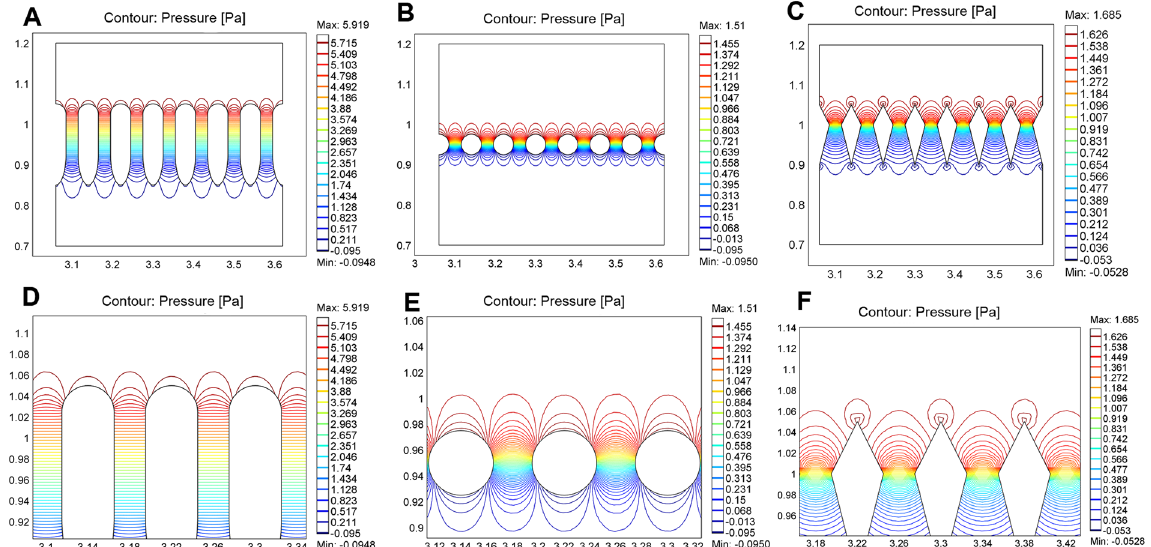
Figure 2. Comparison of pressure contours for three microfluidic chips composing of three distinct microposts. ( A ) Pressure contour for ellipse microposts array. ( B ) Pressure contour for circular microposts array. ( C ) Pressure contour for prismatic microposts array. ( D ) Pressure contour for magnified ellipse microposts array. ( E ) Pressure contour for magnified circular microposts array. ( F ) Pressure contour for magnified prismatic microposts array.